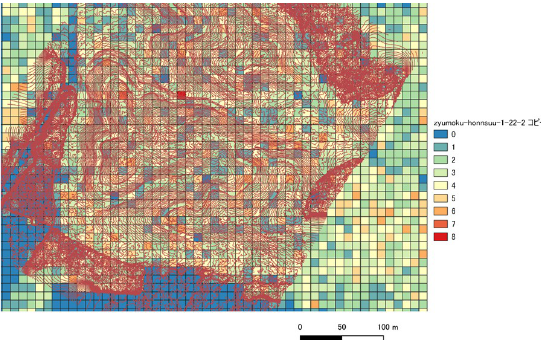
Figure 16 . Relationship between LiDAR transmittance and total cross-sectional area in Onigajo site.